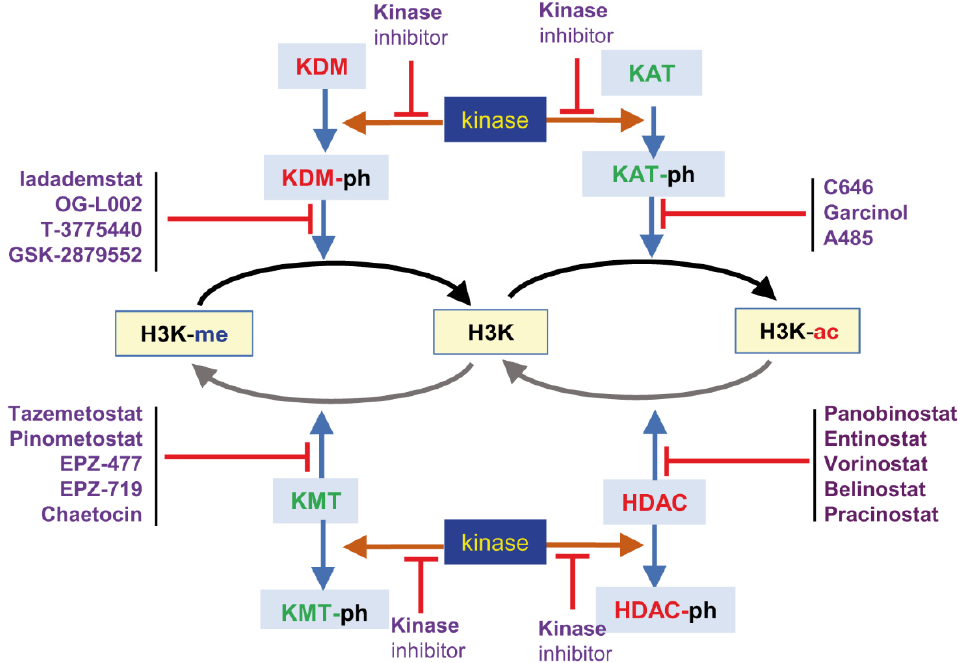
Figure 2. Alternative covalent modifications, methylation or acetylation of histone H3K in different residues, by enzymes mediating the alternative epigenetic modifications, the effect of regulatory phosphorylation coordinating the modifications and drugs targeting different epigenetic enzyme activities. These epigenetic drug combinations can vary depending on the specific lysine residue modified in individual H3 histone tails or in combination with additional modifications in any of the other histones in the nucleosome. Therefore, there is a very large number of potential combinations that need to be identified and tested in specific tumor types or stages.